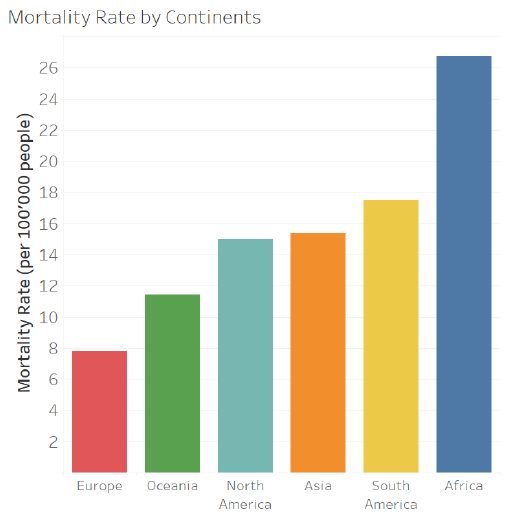
Fig. 1 . Mortality Rate (per 100,000 people) distribution according to the continent